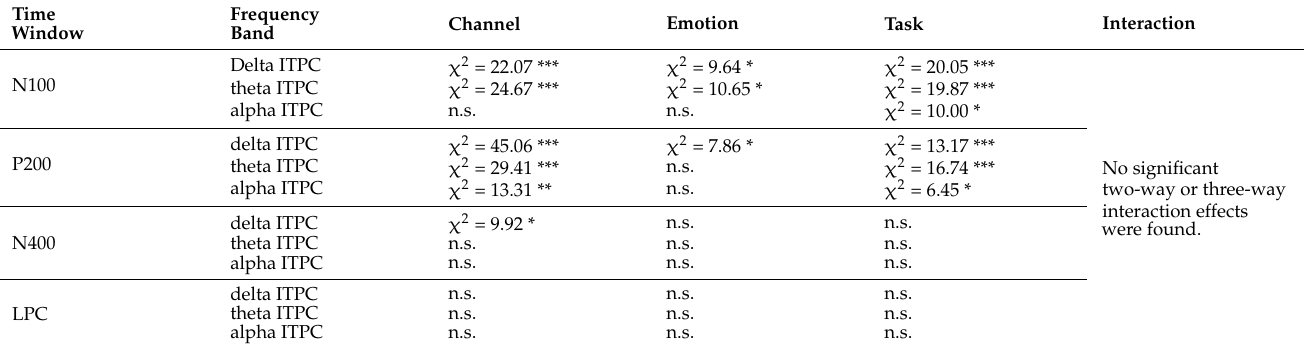
Table 2. Effects that reached significance for ITPC